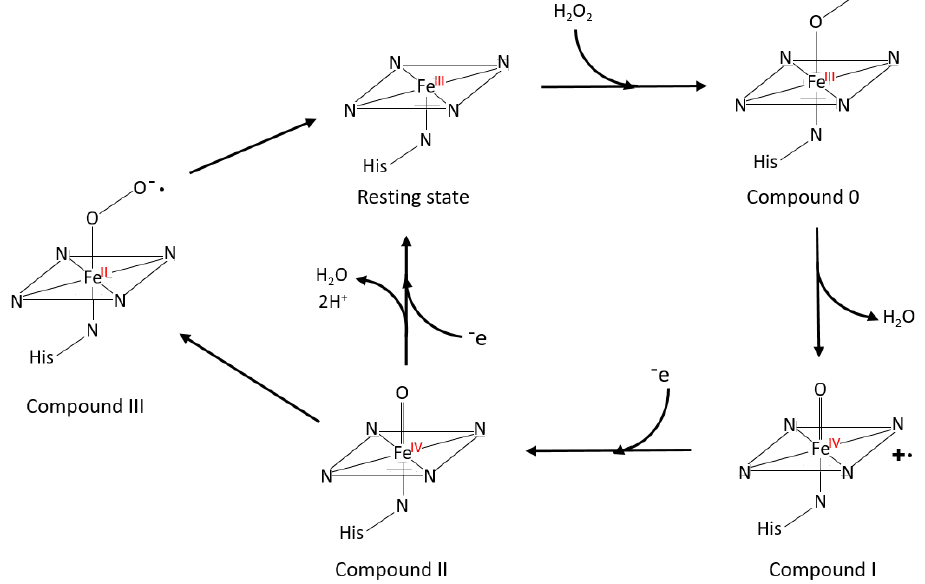
Figure 4. General catalytic cycle of heme peroxidases.